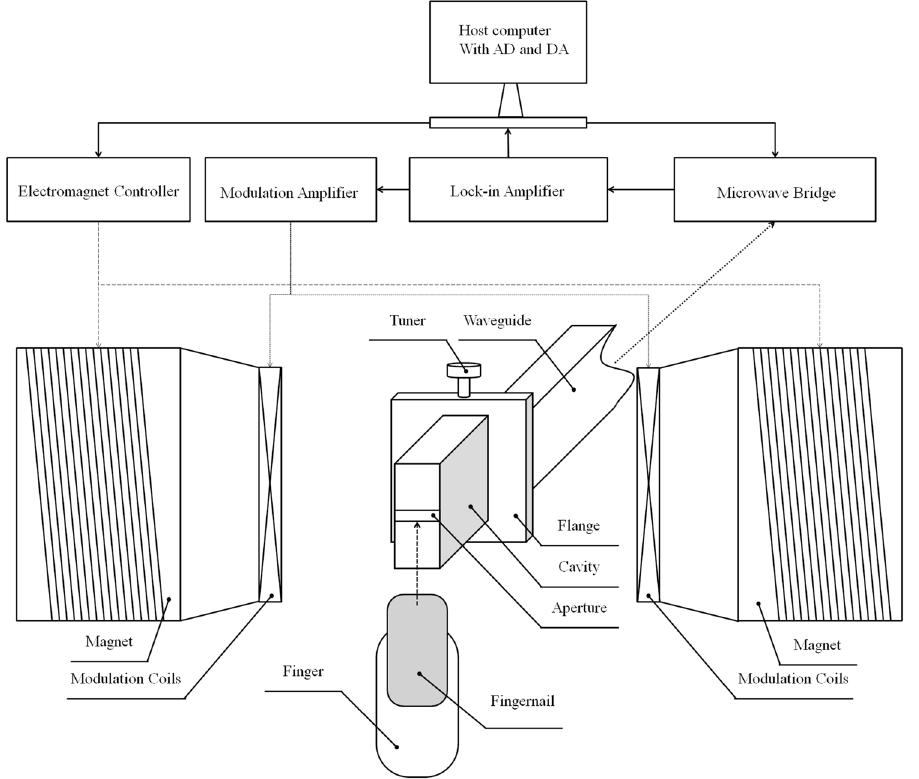
Figure 1. The system design of in vivo fingernail